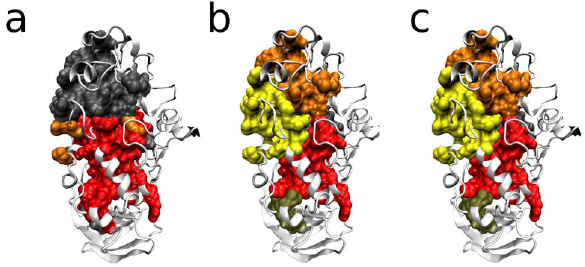
Figure 4. a -amylase homologs. Clusters (modules) found in an extension of the modularity inference performed in [1], inclusing 135 homologs of the catalytic domain of the a -amylase. a) Modules inferred without constraining the topology with inter-residue contacts. b) Modules inferred constraining the topology in A with inter-residue contacts. c) Modules inferred by prefiltering the results in B, before significance testing.